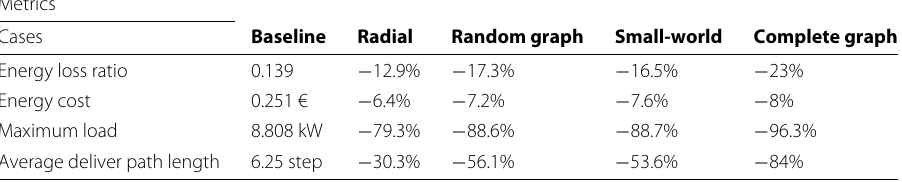
Table 1 The cases’ comparison of the performance